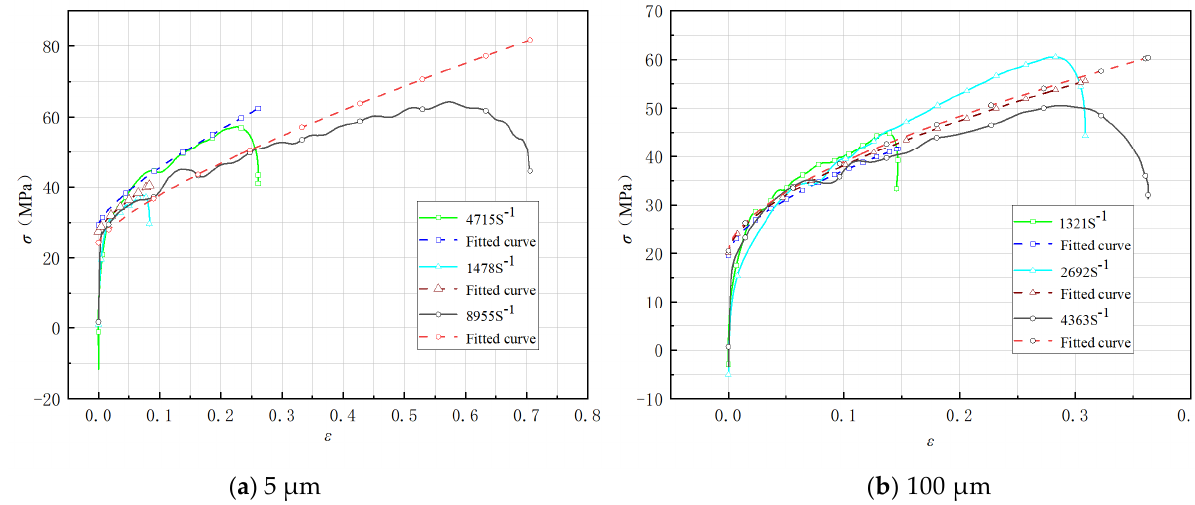
Figure 8. Stress–strain curves under different aluminum particle sizes.